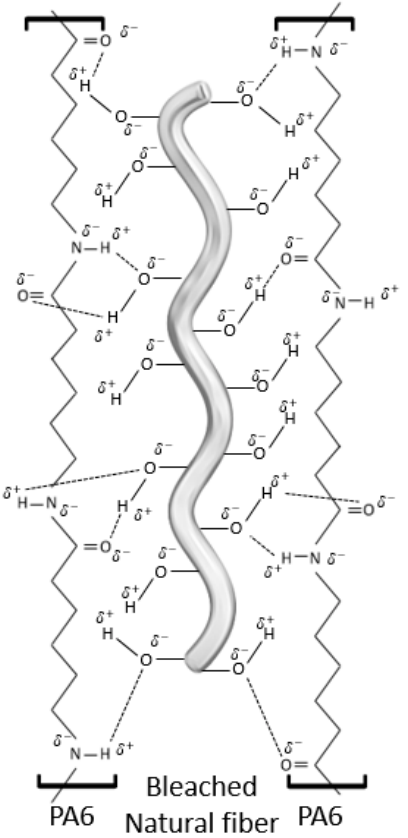
Figure 3. Proposed mechanism of bleached fibers anchoring onto PA6 surface.